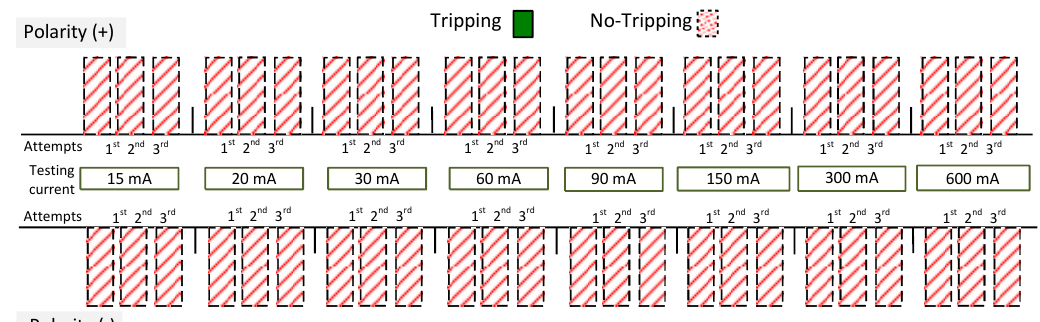
Figure 21. Tripping of the 30 mA A-type RCDs for a pure direct current (suddenly applied) of values 15, 20, 30, 60, 90, 150, 300 and 600 mA. Tested RCDs: ( a ) (RCD30_6); ( b ) (RCD30_7); ( c ) (RCD30_1); ( d ) (RCD30_8).